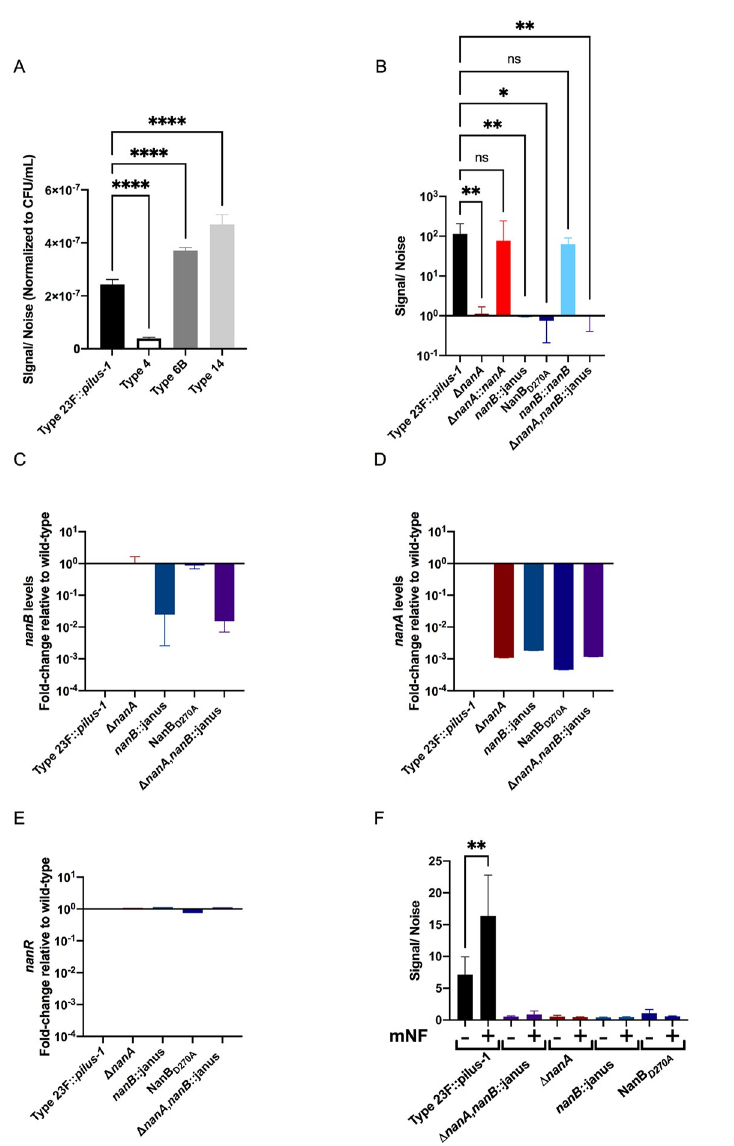
Fig 4. NanB regulates nanA in a sialic acid-dependent manner. (A-B) Neuraminidase activity by Spn was quantified using NA-STAR kit (Thermo-Fischer Scientific, USA). Pneumococcal isolates of different serotypes ( A ), or the defined isogenic mutants of Type 23F:: pilus-1 ( B ) were grown up to 1x10 8 CFU/mL, centrifuged and resuspended in PBS at a density of 10 7 CFU/mL. Bacterial suspensions were then sonicated (Amplitude, 8 μ m) and the supernatant incubated in buffer and NA-STAR substrate for 20 min at room temperature before reading the chemiluminescent signal. To analyze the data, the signal was divided by the noise (PBS control). (A-B) Experiments were performed in duplicate and mean values of three independent experiments are shown with error bars corresponding to S.D. �� ,p < 0.01; ���� , p < 0.0001 by ordinary one-way ANOVA followed by Dunnett’s multiple comparison test for multiple comparisons (C-E) Transcription level of nan genes was measured using quantitative RT-PCR. Spn strains were grown in TS at 37˚C to OD 620 = 1.0 followed by RNA extraction. Data shown as the fold-change was calculated relative to wild-type (Type 23F:: pilus-1 ) for (C) nanB (D) nanA (E) nanR . Mean values of two independent experiments performed in duplicate are shown. (F) Neuraminidase levels and activity in response to sialic acid found in mNLs were also assessed using the NA-STAR kit. Type 23F:: pilus-1 and isogenic mutants were grown in TS for 1hr, spun down and resuspended in DMEM. These samples were added at a 1:50 dilution to DMEM alone, or DMEM with mNL. They were incubated at 37˚C and 5% CO 2 for 3 hours, centrifuged and resuspended in PBS. Samples were then treated in the same manner as Fig 4B. The experiment was performed in duplicate and mean values of 3 independent experiments are shown with error bars corresponding to S.D. �� ,p < 0.01 by an unpaired T-test to compare control to treatment.